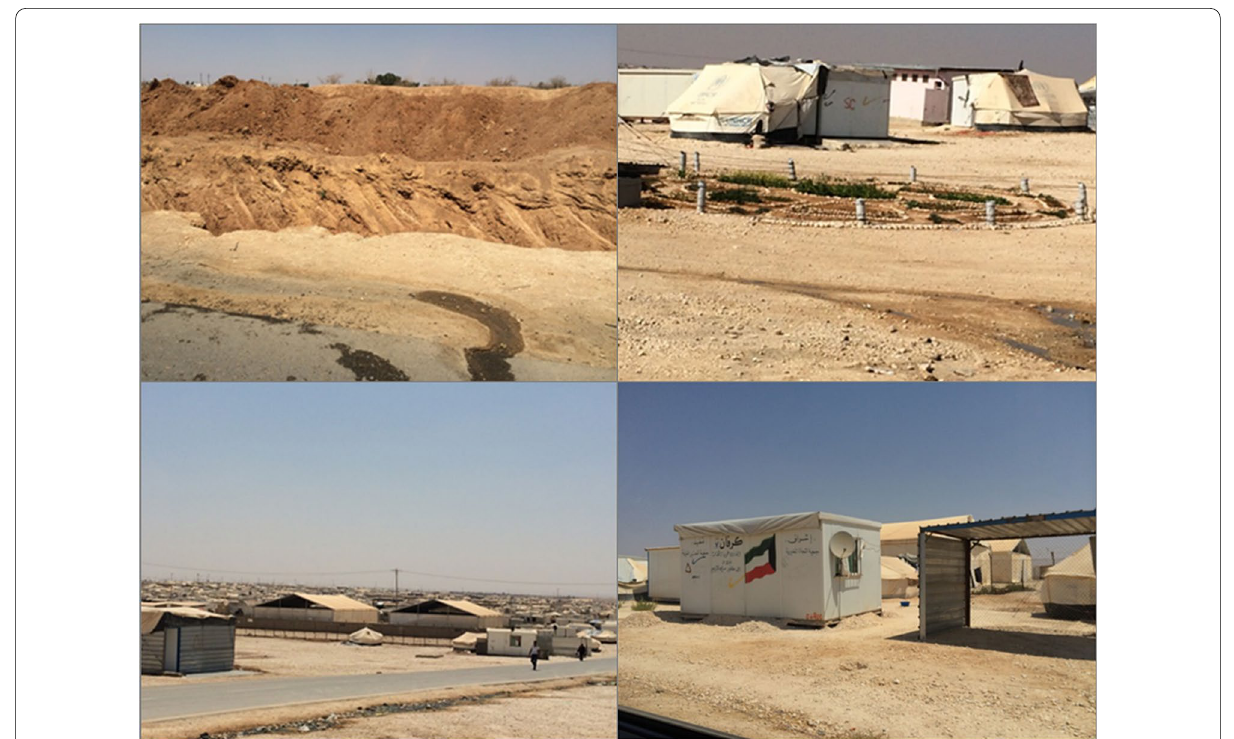
Fig. 6 Informal layout in the Al Za’atari camp in Jordan (Source: Author 2013–2015)